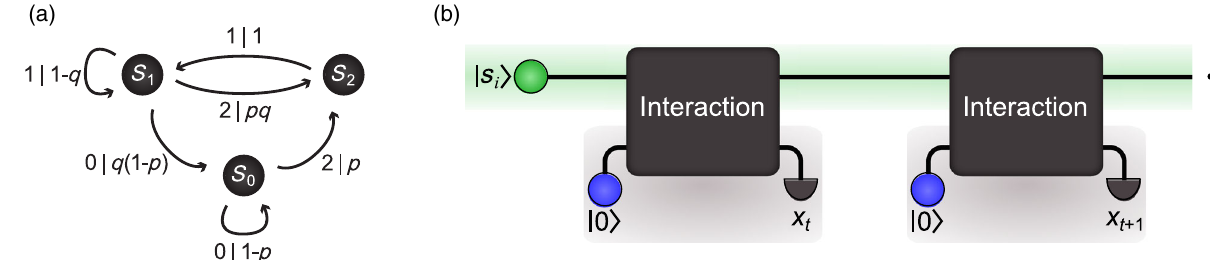
FIG. 1. The stochastic process and its simulation. (a) The simplest classical simulator for the process can be represented by a directed graph. Here, the three nodes S 1 , S 2 , and S 3 represent internal states of the machine. Each edge between two nodes, S j and S k , labeled r j T T r and transitions from state S S jk , represents the probability jk that the machine emits output j to state k . To generate correct conditional futures, one first initializes the machine in state S i depending on the value of the last output (0, 1, or 2). Iterating the machine can then generate correct conditional future statistics. Mathematically, the probabilities T jk make up the transition matrix, whose eigenvalues form the probability distribution of the causal states, called the stationary distribution f p i g i . (b) Dynamically, a ¼ 0 ; 1 ; 2 simulator can be considered to consist of a memory (upper arm) that transfers information between time steps and sequentially interacts with a blank tape (lower arm) at each time